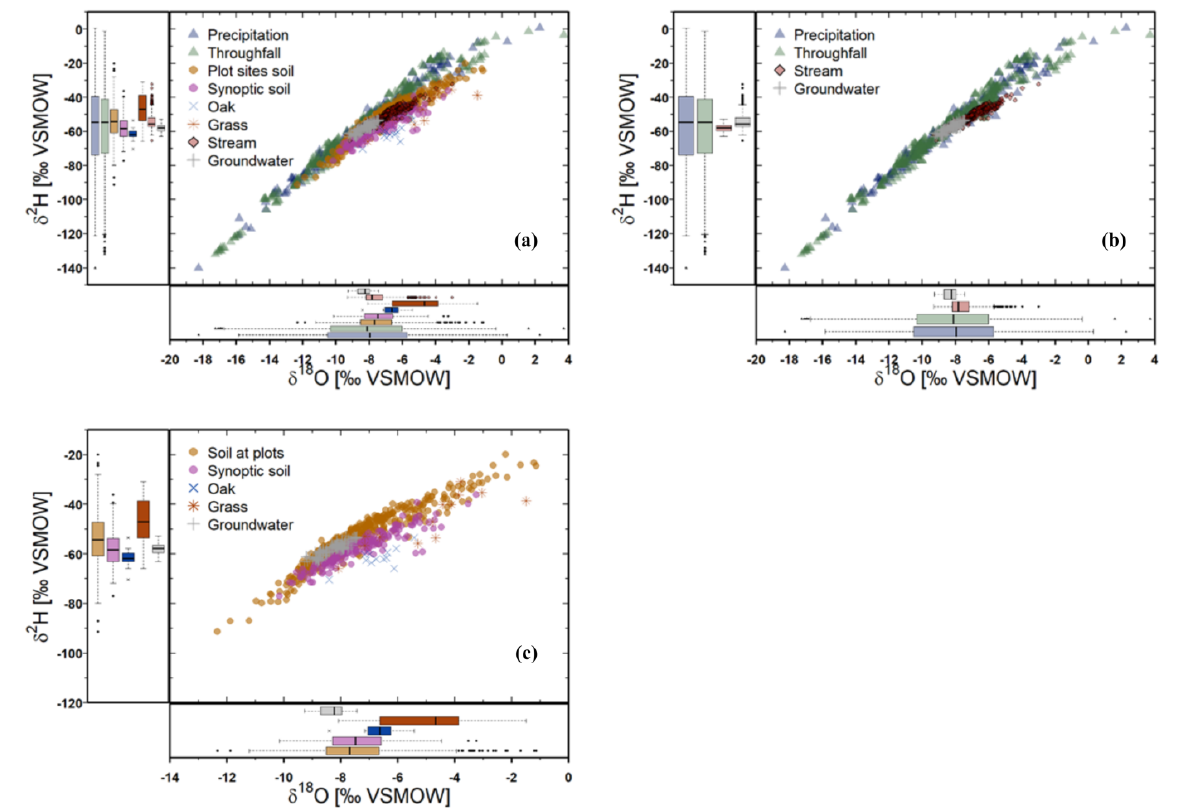
Figure 6. Dual-isotope-space ( δ 2 H– δ 18 O) plots for (a) all measured isotopic data sets (for all locations), (b) precipitation, throughfall, streamwater, and groundwater, and (c) soil (multiple depths), synoptic soil survey (upper 30cm), vegetation, and